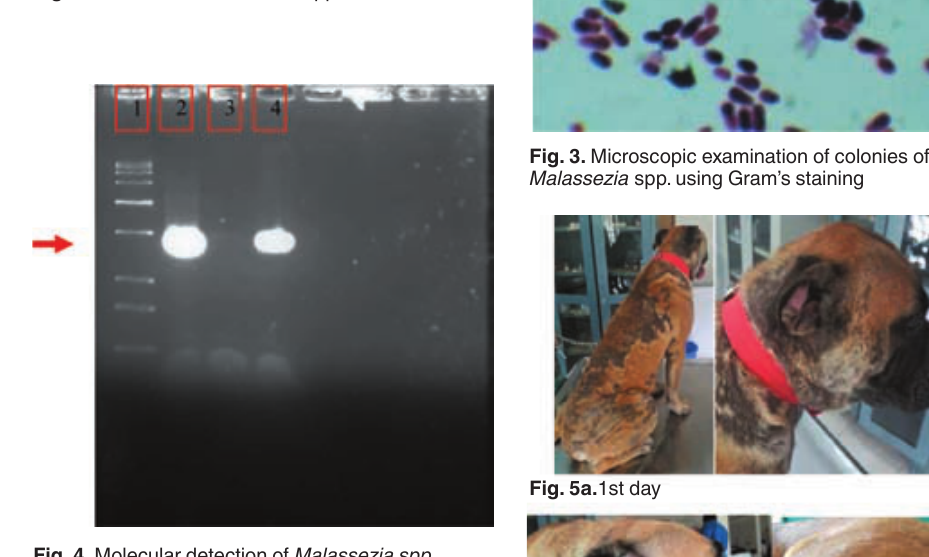
Fig. 4. Molecular detection of Malassezia spp. (Lane 1 – 100 bp ladder ; Lane 2, 4 – Isolates of Malassezia spp .; Lane 3 – Negative control; Amplicon size between 541 bp and 579 bp )